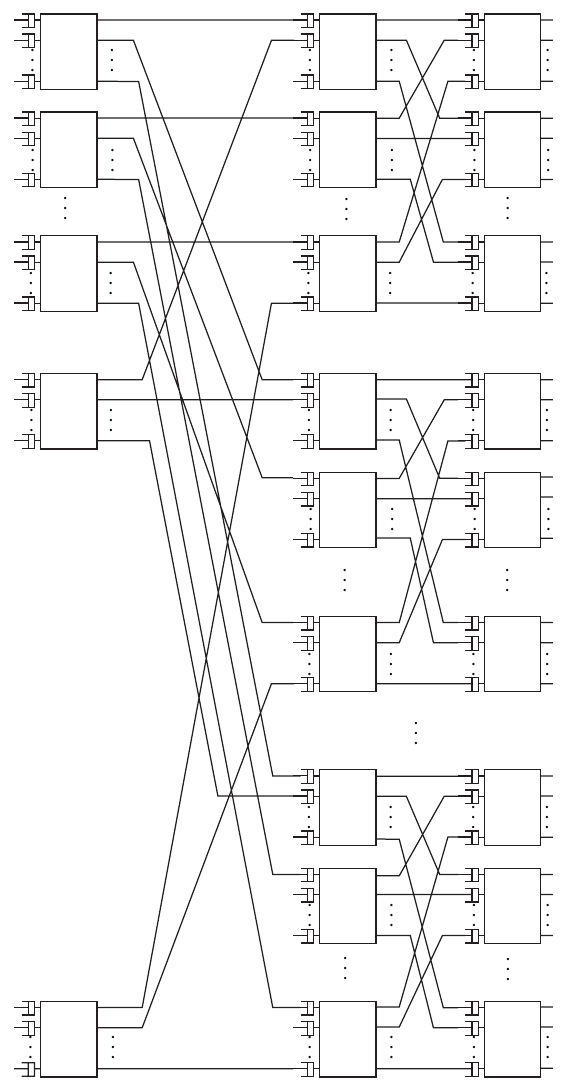
Figure 1: A 3-stage Delta